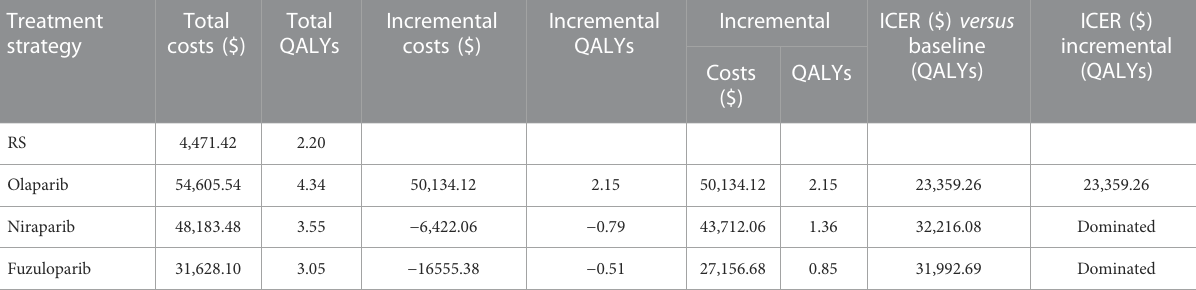
TABLE 2 Results of cost-effectiveness of fuzuloparib, olaparib and niraparib. Treatment